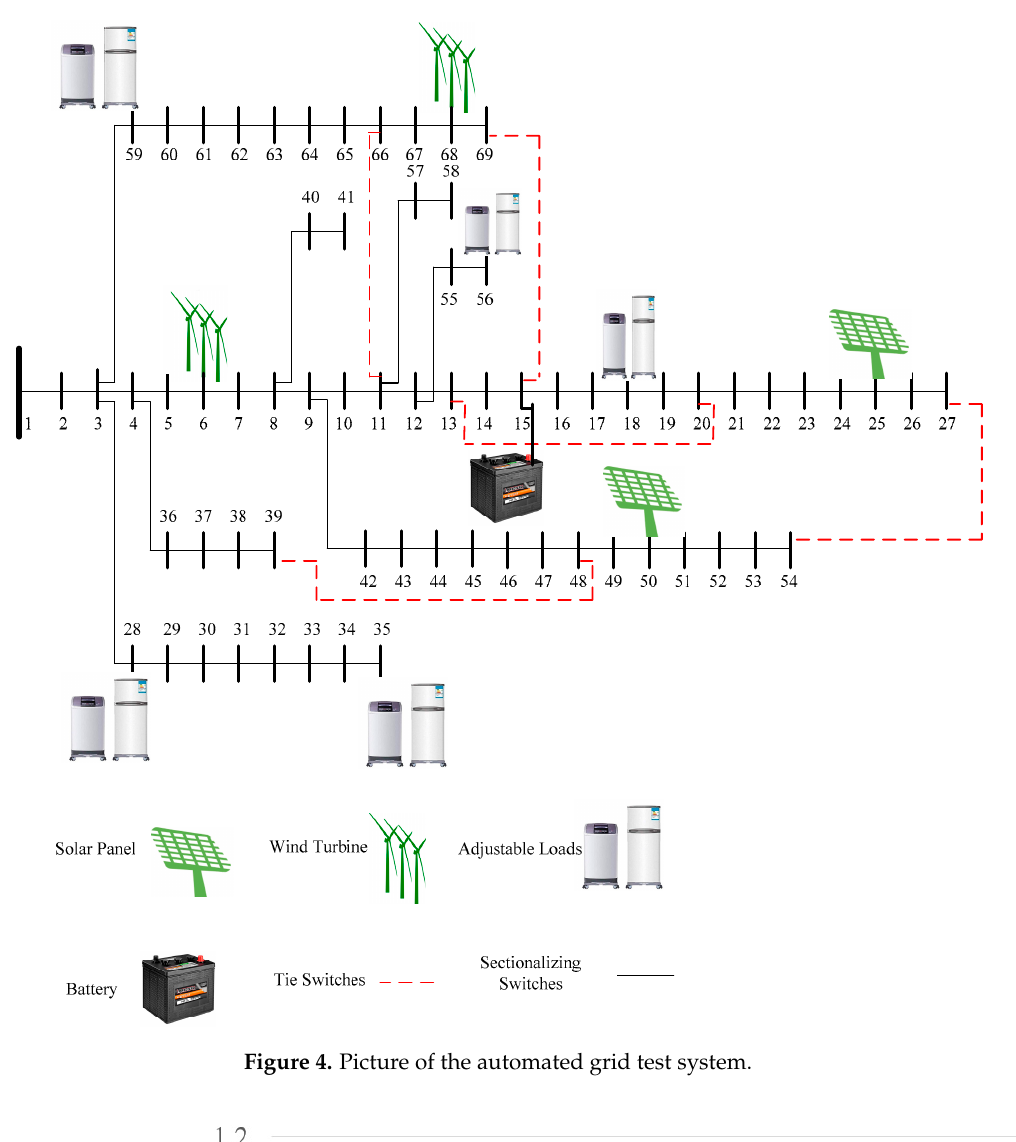
Energies 2021 , 14 , x FOR PEER REVIEW 14 of 27 Figure 4. Picture of the automated grid test system. Figure 4. Picture of the automated grid test system.